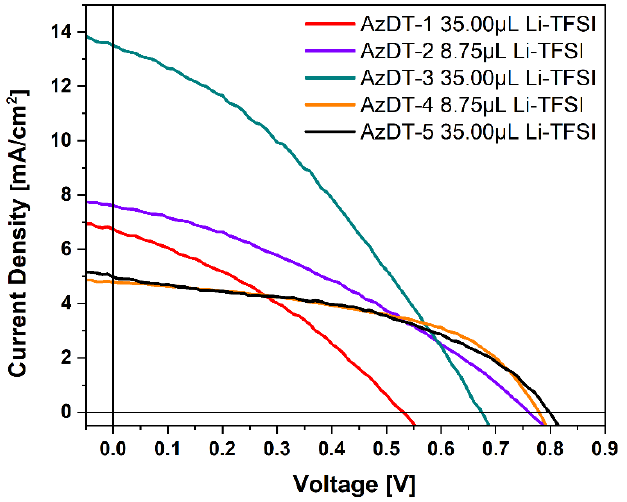
Figure 8. The current-voltage (I–V) characteristics for selected hybrid perovskite solar cells devic- es.